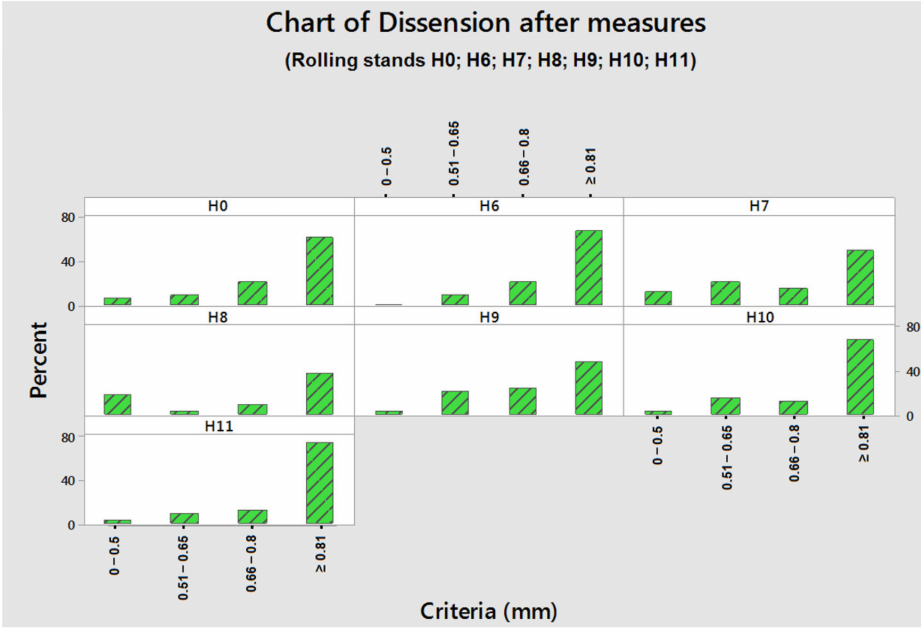
Figure 8. Bars of stands after measures—Overall. Source: own research.